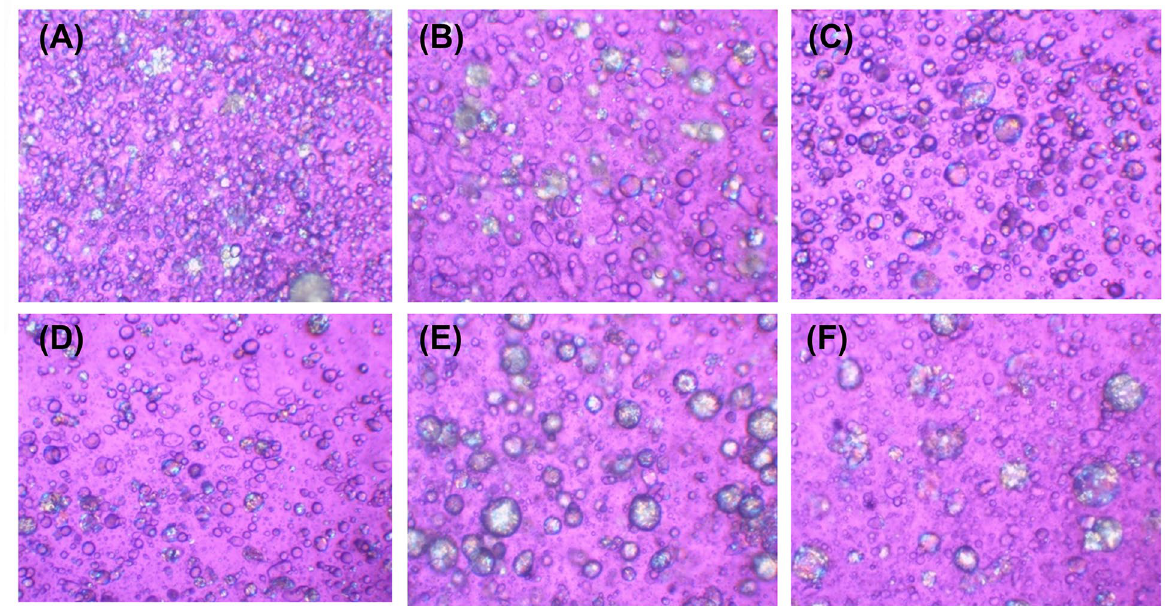
Figure 7. Liquid crystal formation under polarized light optical microscope (magnification 10×) of formulation containing Simmondsia chinensis (jojoba) oil ( A ), Prunus dulcis (almond) oil ( B ), Perilla ocymoides (perilla) seed